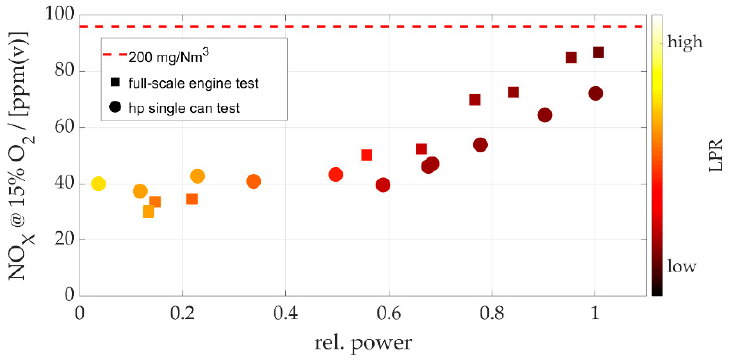
Figure 19. NO X emissions with respect to relative power; color represents the Liquid-Pilot Ratio (LPR); circles denote high-pressure test results and squares full engine tests, respectively.